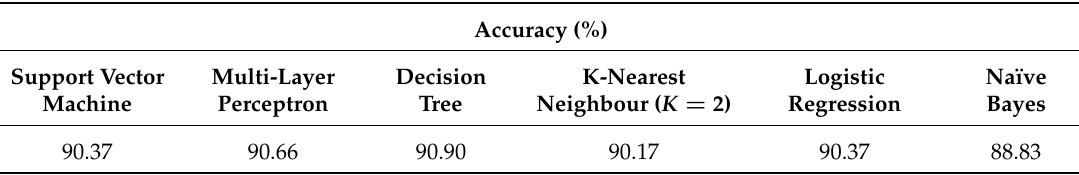
Table 4. Comparison of classifiers accuracy for